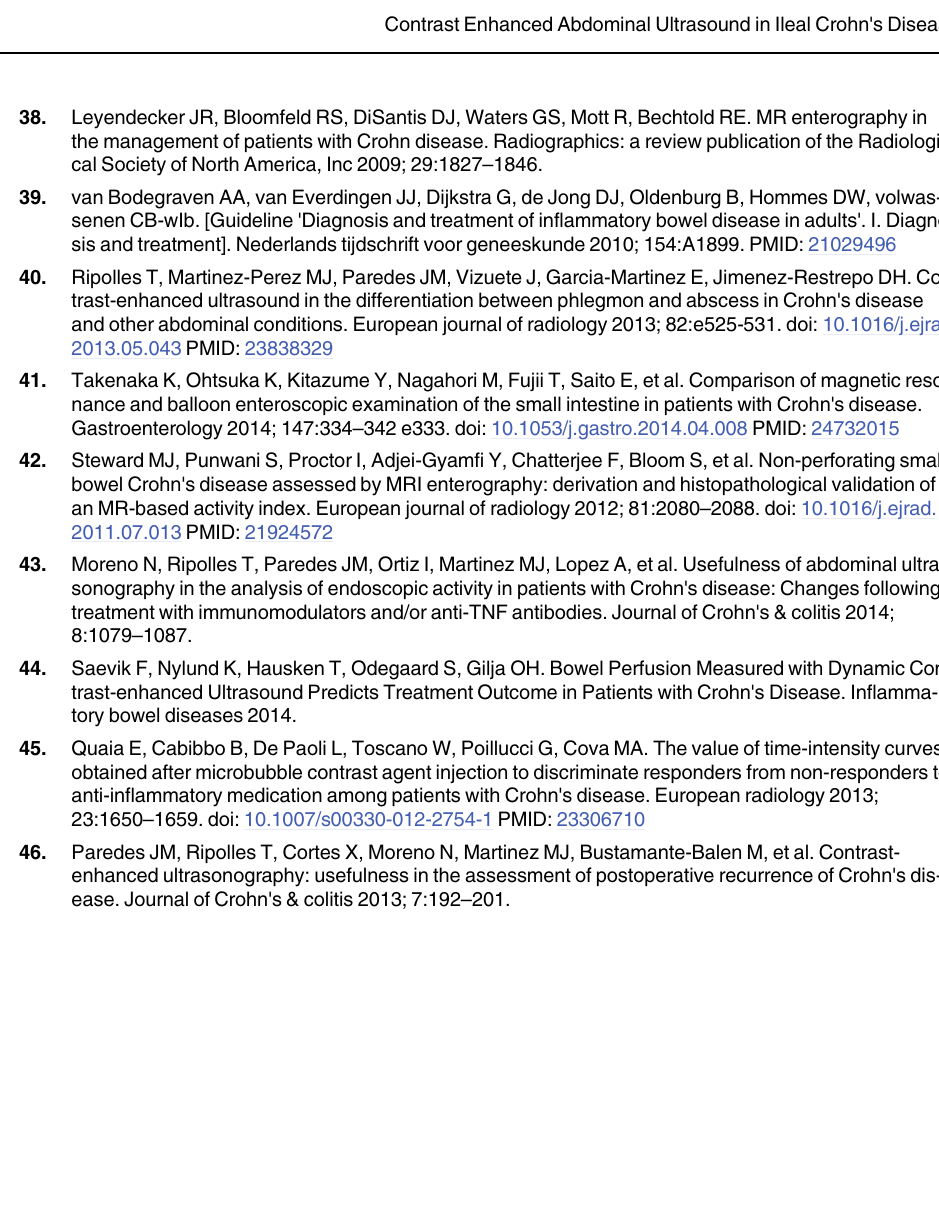
PLOS ONE | DOI:10.1371/journal.pone.0136105 August 31,